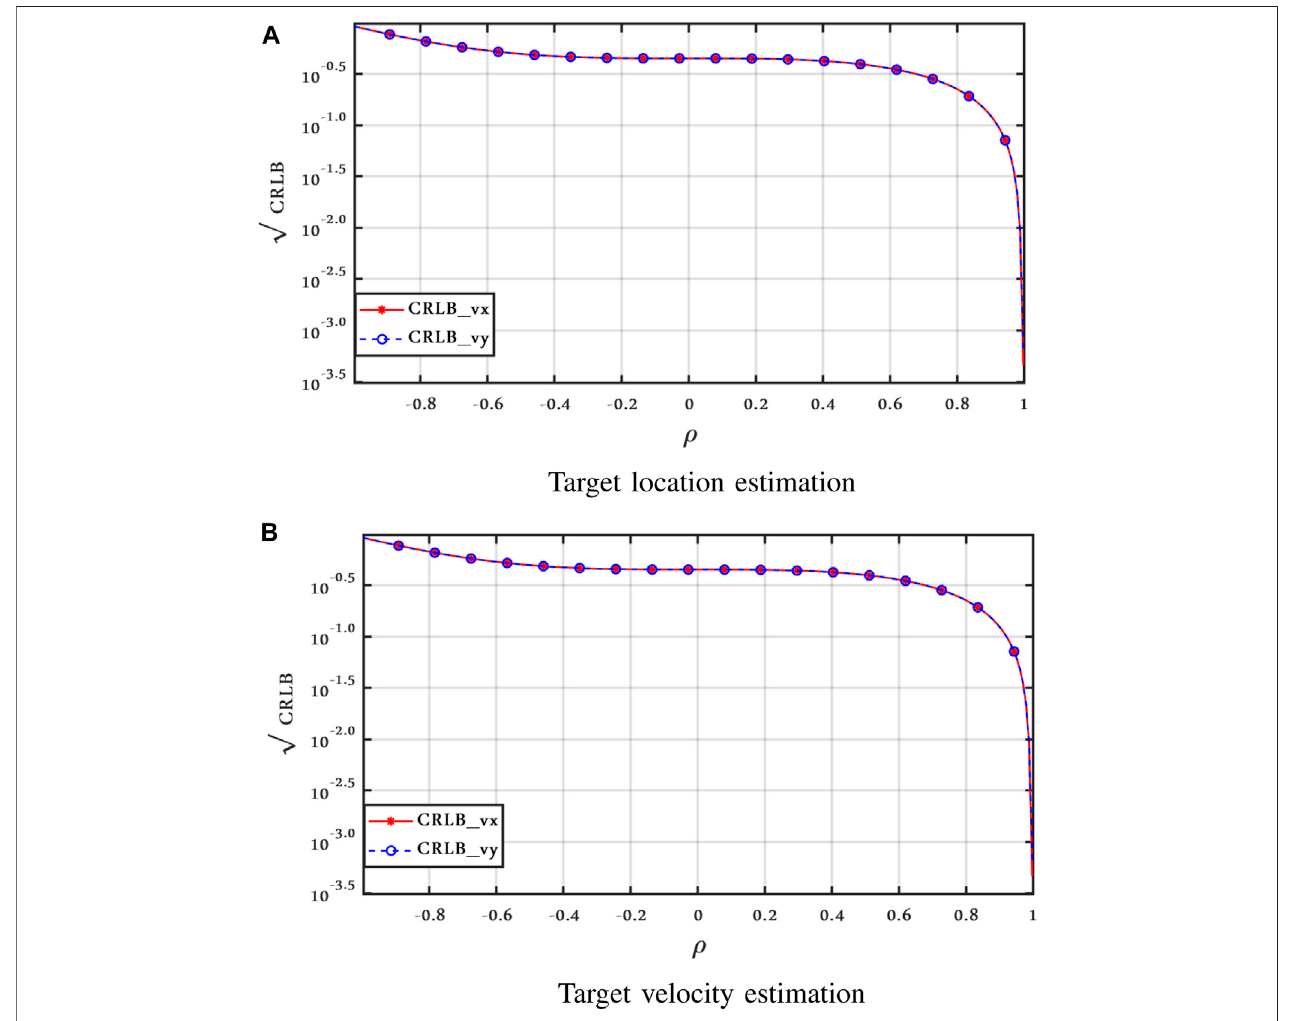
FIGURE 7 | CRLBs vs. ρ , Clutter Model II with ] = 2.1, SCR = 0 dB , and v x = v y = 0 m/s.